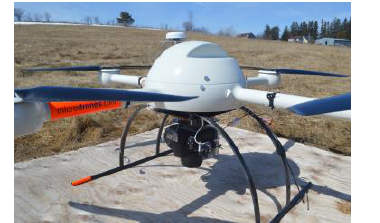
Figure 3: Microdrones md4-1000 VTOL UAV with APX-15 UAV and dSLR camera